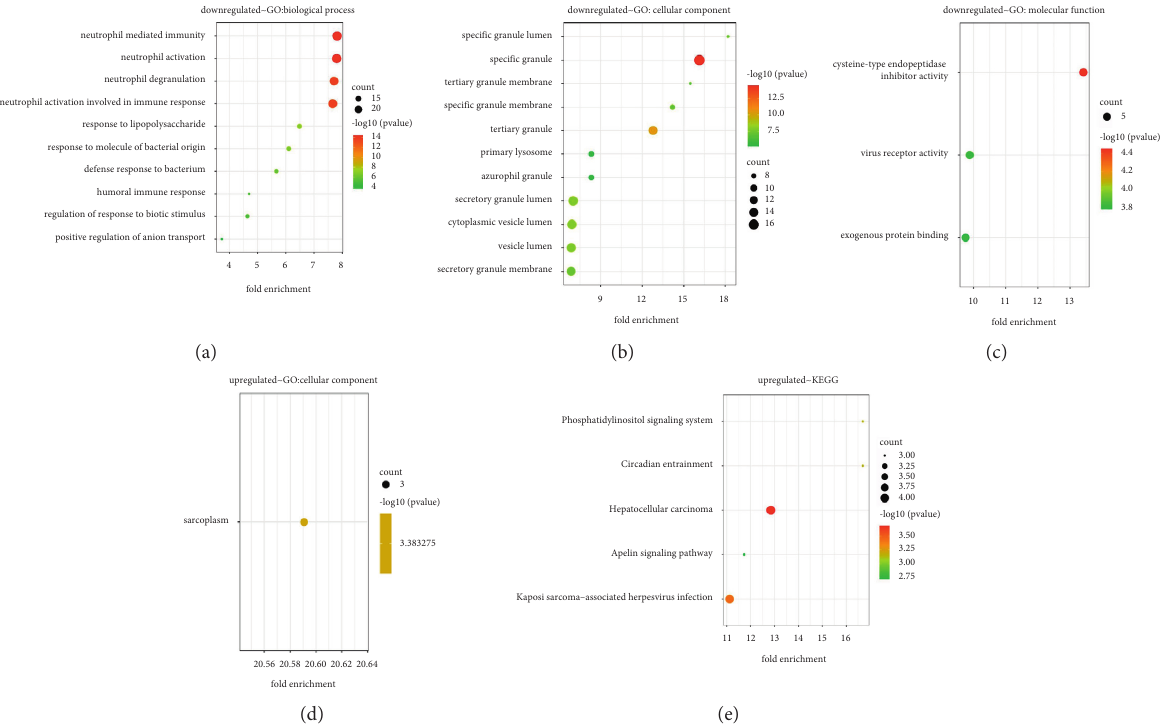
Figure 3: The gene ontology (GO) and Kyoto Encyclopedia of Genes and Genomes (KEGG) pathway enrichment analysis of differentially expressed genes. The biological process (BP), bellular component (CC), and molecular function (MF) consist of GO enrichment analysis commonly. (a) The enrichment dot bubble of GO-BP analysis, (b) the enrichment dot bubble of GO-CC analysis, and (c) the enrichment dot bubble of GO-MF analysis derived from downregulated DEGs. (d) The enrichment dot bubble of GO analysis derived from upregulated DEGs. (e) The enrichment dot bubble of KEGG analysis derived from